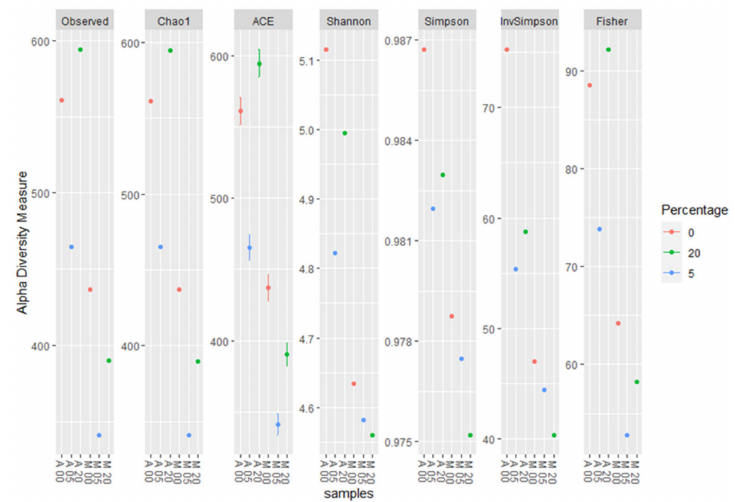
Figure 7. Alpha diversity of the soil fungal community according to the observed OTU, Chao1, Shannon, Simpson, and Fischer indices.